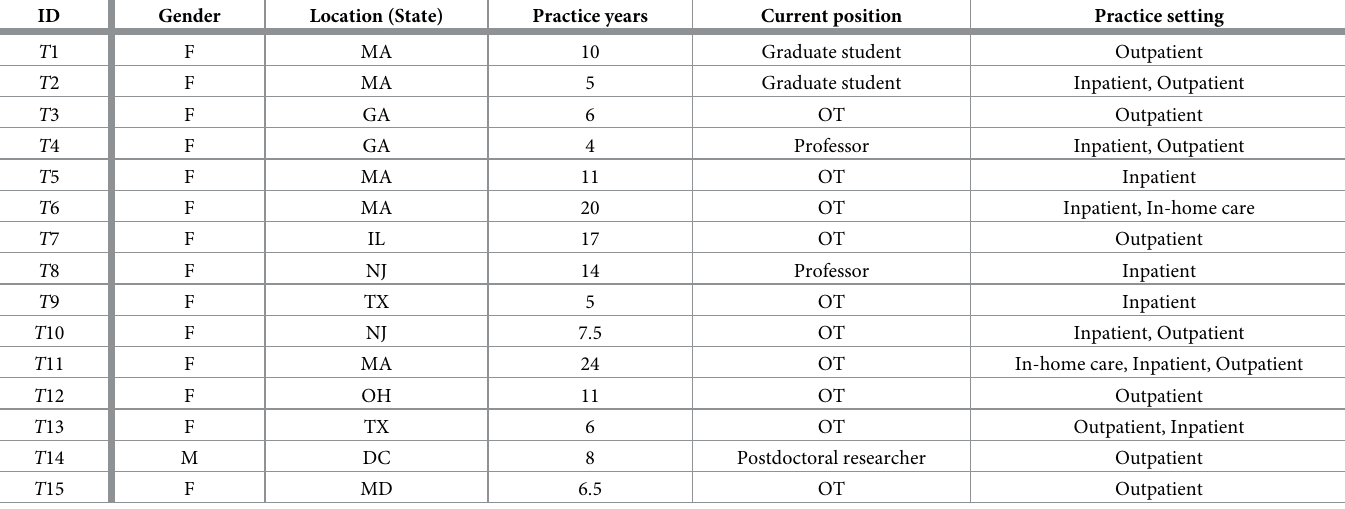
gate stroke survivors’ perspectives and experiences on wearing finger-worn sensors in their daily living and (2) to collect sensor-generated data to create study probes for the stroke survi- vors as well as OTs. The eligible study participants were assessed for their cognitive capacity (measured by Mini-Mental State Examination), motor capacity (measured by Fugl-Meyer Table 2. The demographic information of the OTs.